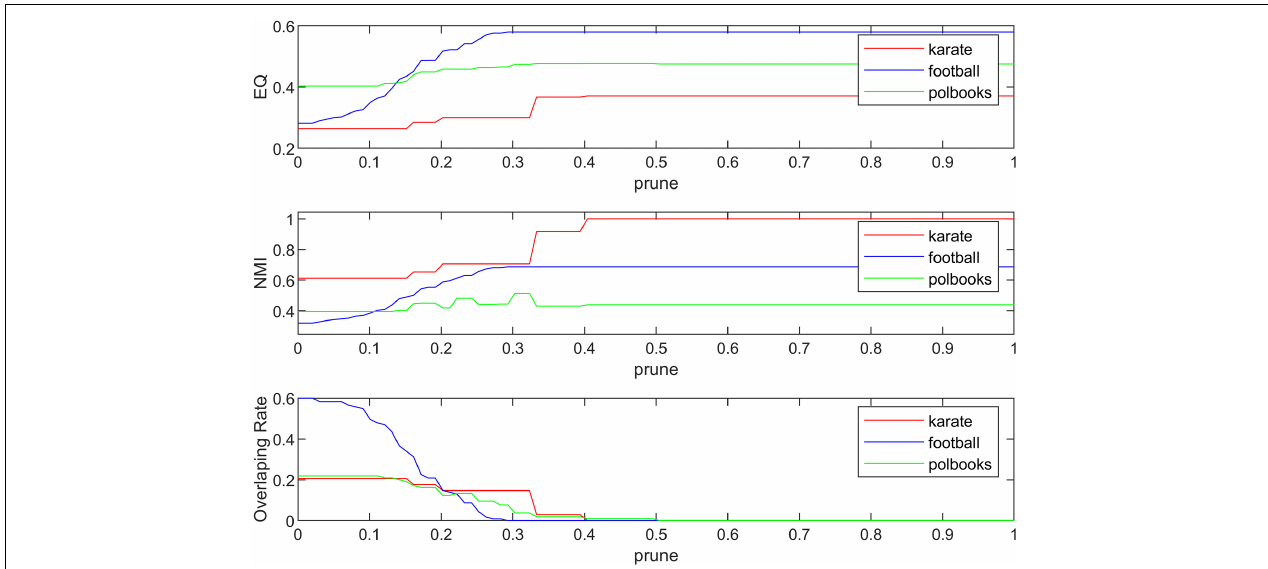
FIGURE 4 | The relationship between EQ, NMI, OR and prune in the standard